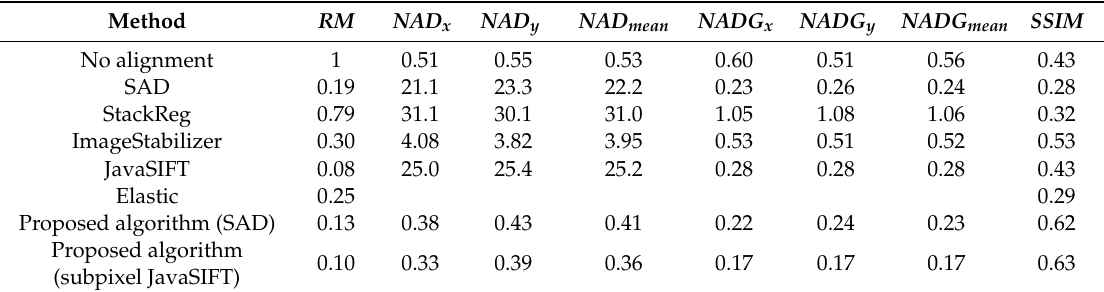
Table 2. Minkowski functionals for the synthetic sample.